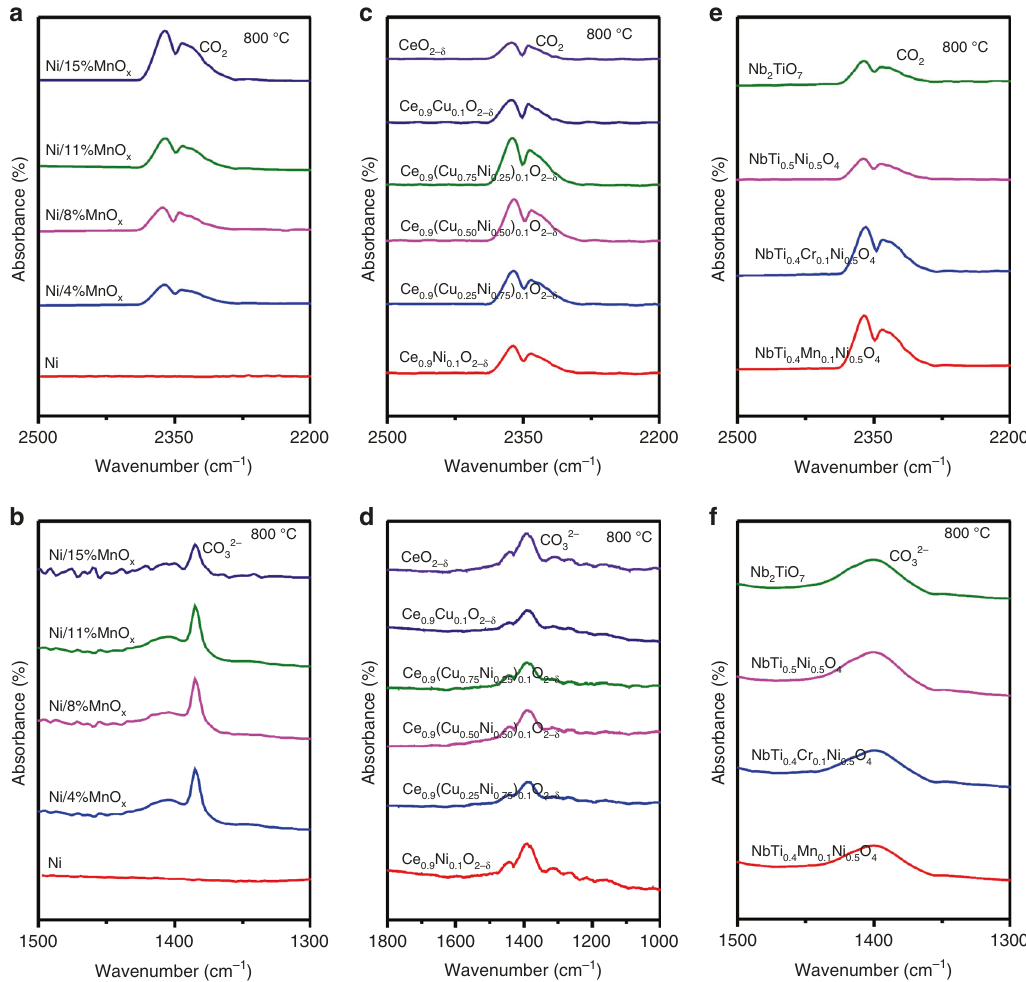
Fig. 4 Chemical adsorption of CO 2 for different samples. a , c , and e In situ FT-IR spectroscopy of CO 2 molecule absorbed on different reduced samples at 800 °C. b , d and f In situ FT-IR spectroscopy of carbonate ion absorbed on different reduced samples at 800